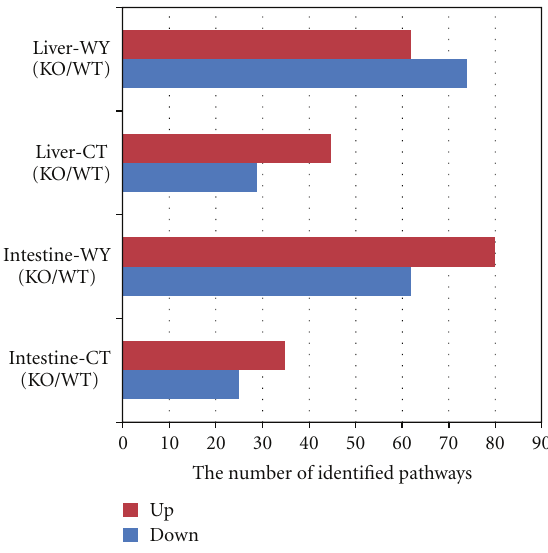
Figure 1: The number of identified up-or downregulated path- ways in four studies of PPAR α -dependent side . The bar chart showing the number of significantly identified pathways ( P ≤ 0 . 01) in our four studies of PPAR α -dependent side according to the data of Additional File 1 which is available online at doi:10:1155/2011/629728. X -axis represents the number of signif- icantly identified pathways; Y -axis represents our four studies. The studies of Intestine-CT (KO/WT) and Liver-CT (KO/WT) are for identifying PPAR α -dependent pathways; the studies of Intestine-WY (KO/WT) and Liver-WY (KO/WT) are for identifying WY14643 PPAR α -dependent pathways, respectively, in mice small intestine and liver. Red color (up) is for upregulated pathways and blue color (down) is for downregulated pathways. There were 35 and 25 in study of Intestine-CT (KO/WT), the study in mouse small intestine of wild type versus PPAR α -null mice treated with normal food in GSE5475; 80 and 62 in study of Intestine-WY (KO/WT), the study in mouse small intestine of wild type versus PPAR α -null mice treated with PPAR α agonist WY14643 for 5 days; 45 and 29 in study of Liver-CT (KO/WT), the study in mouse liver of wild type versus PPAR α -null mice treated with normal food; and 62 and 74 in study of Liver-WY (KO/WT), the study in mouse liver of wild type versus PPAR α -null mice treated with the PPAR α agonist WY14643 for 5 days, respectively, for up-and down-regulated pathways.